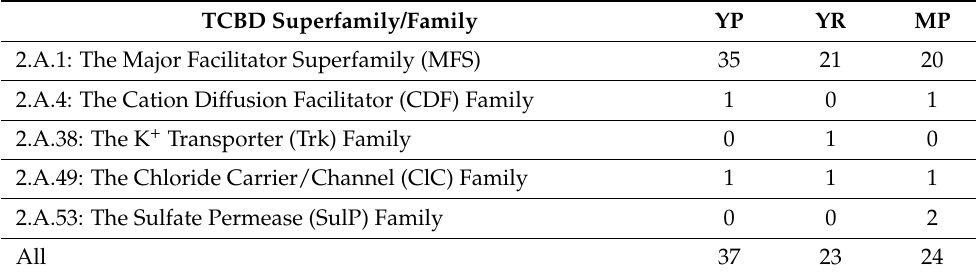
Table 6. Porters (uniporters, symporters,